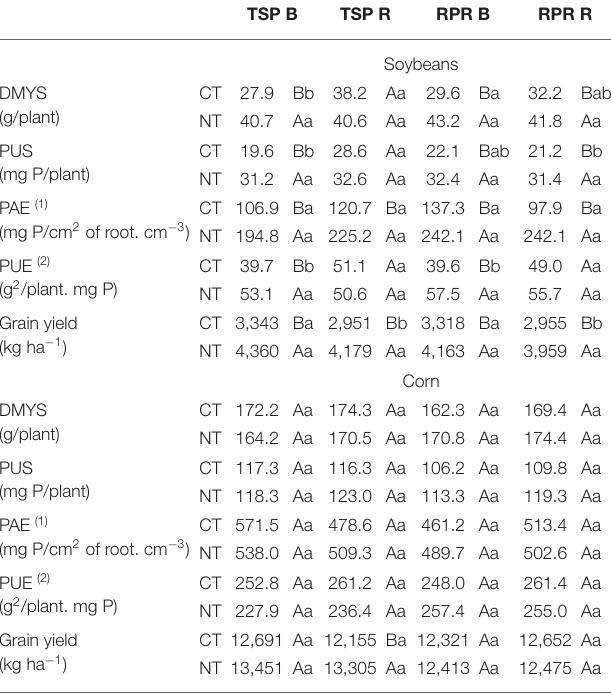
TABLE 5 | Dry matter yield of shoot (DMYS), P uptake of shoot (PUS), P acquisition efficiency (PAE), P utilization efficiency (PUE) and grain yield of soybean (16th cultivation) and corn (17th cultivation) in a very clayey Oxisol under conventional tillage (CT) or no-tillage (NT), receiving 35kg P ha yr − 1 as triple superphosphate (TSP) or reactive phosphate rock (RPR), with broadcast (B) or row (R)